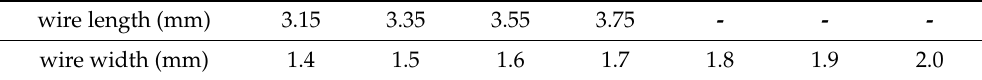
Table 2. Selected line length and line width.